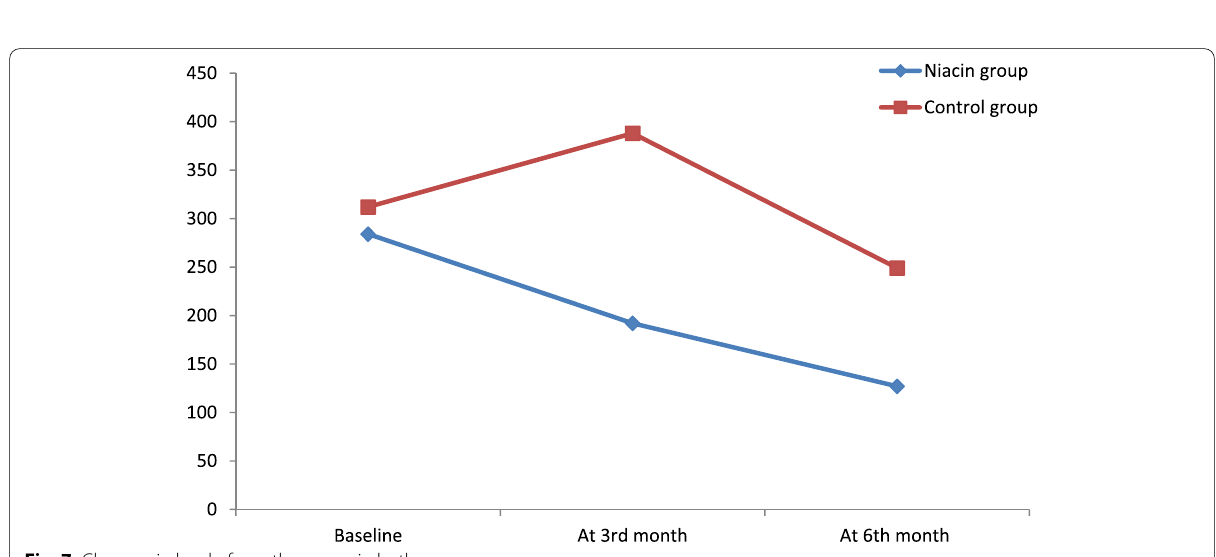
Fig. 7 Changes in level of parathormone in both